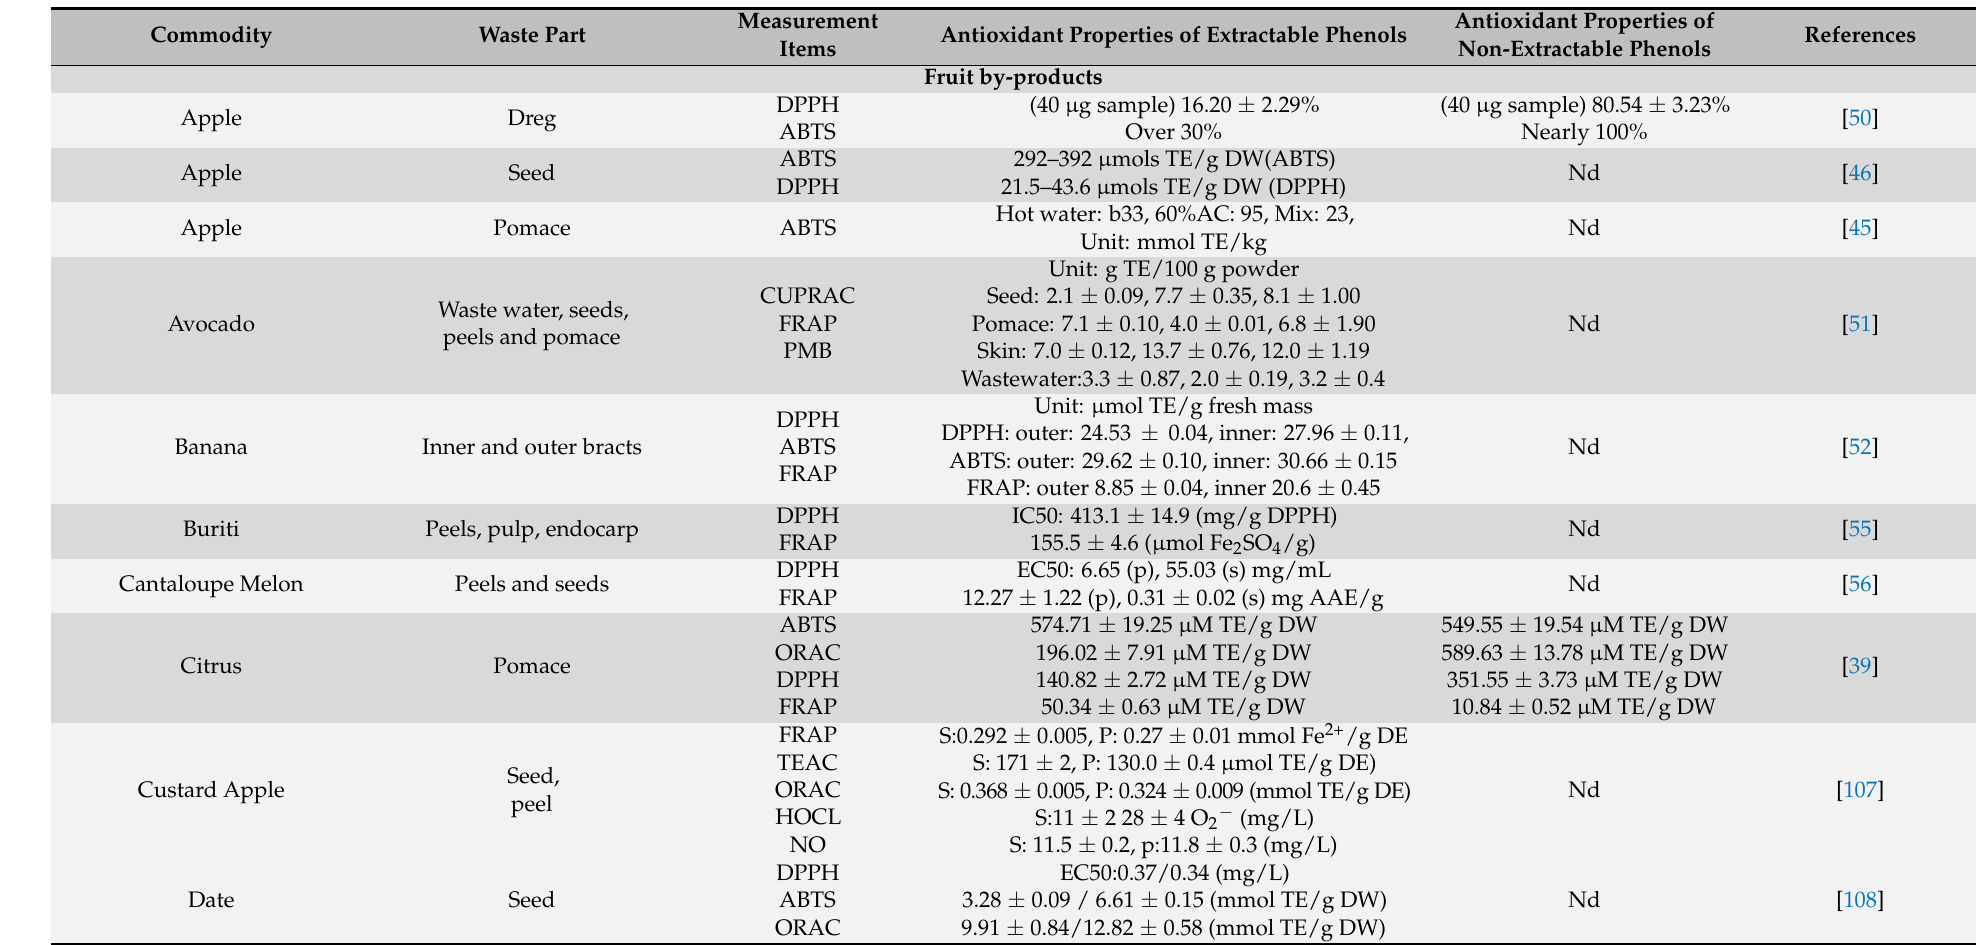
Table 2. The antioxidant properties of extractable and non-extractable phenolic compounds present in F&Veg